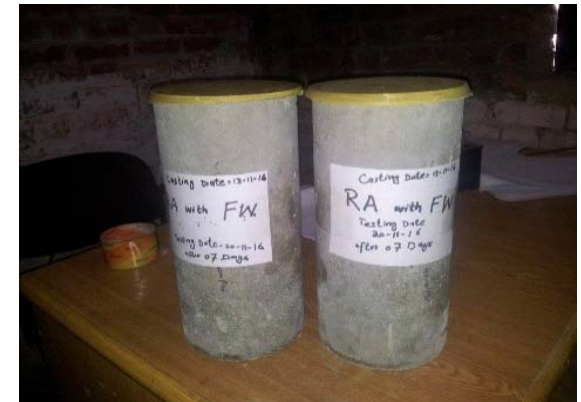
FIG. 3. MEASURING THE WORKABILITY OF CONCRETE (UOL LAB)